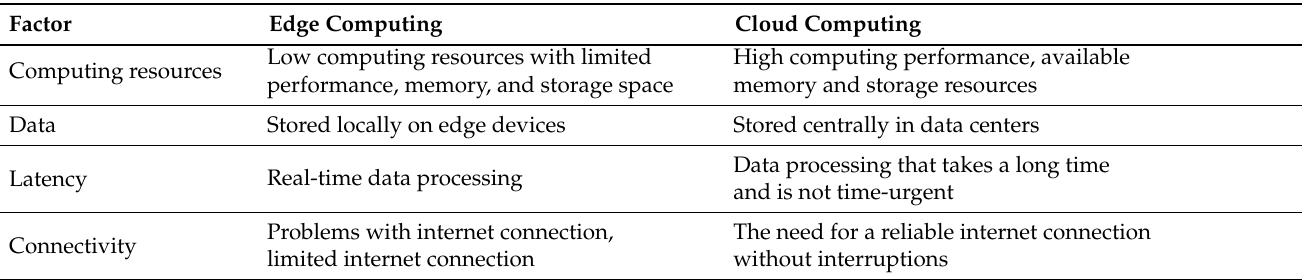
Table 4. Edge and Cloud